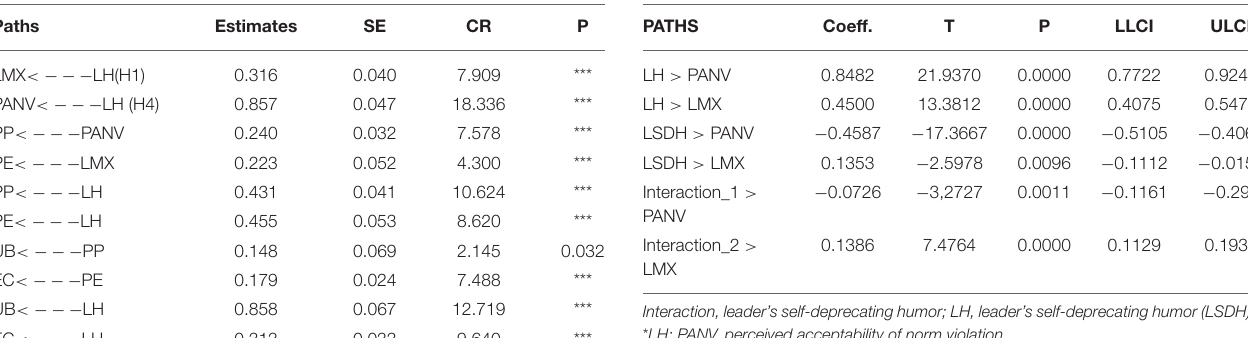
TABLE 5 | Summarized results of moderating variable.